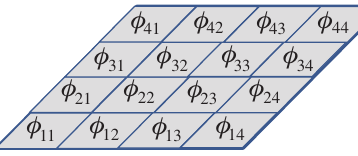
Figure 1: Schematic of a metasurface for phase